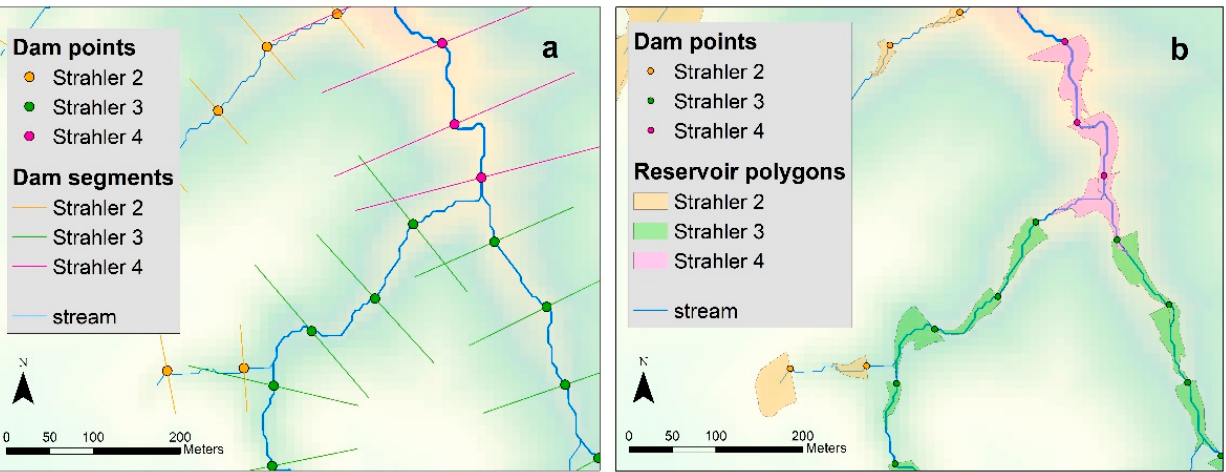
Figure 4. Small reservoir modeling consists of ( a ) identifying locations along streamlines and ( b ) delineating reservoir footprints using elevation lines.